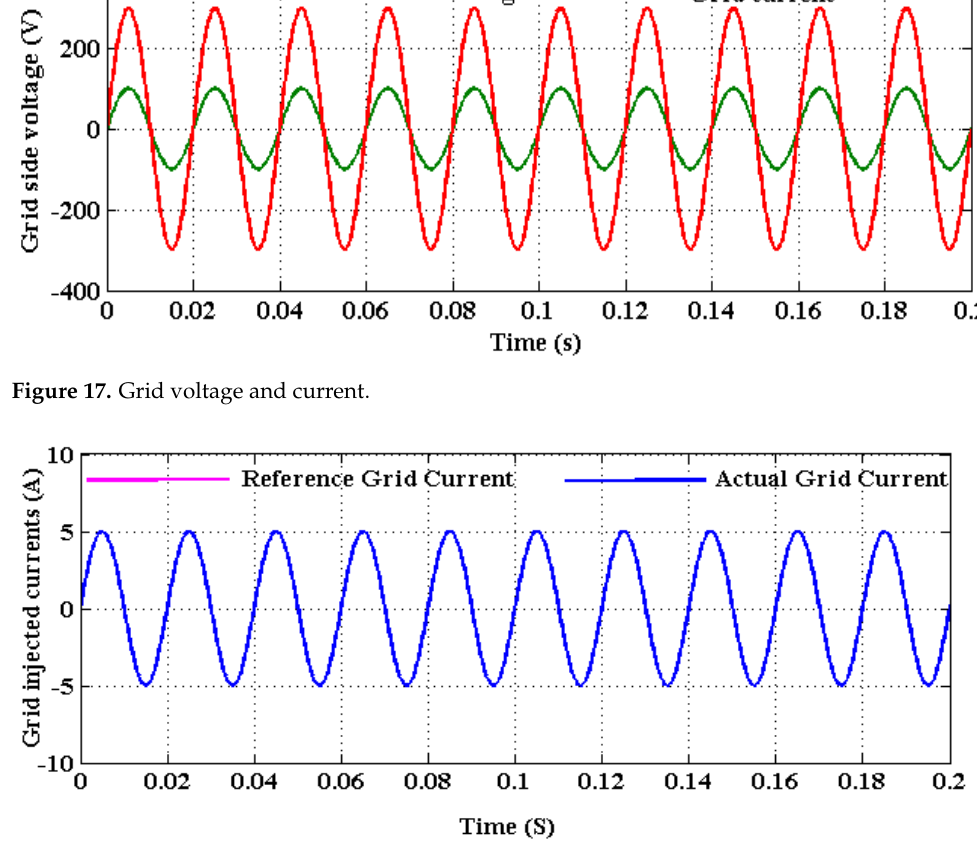
Figure 18. Reference grid current and actual grid current.